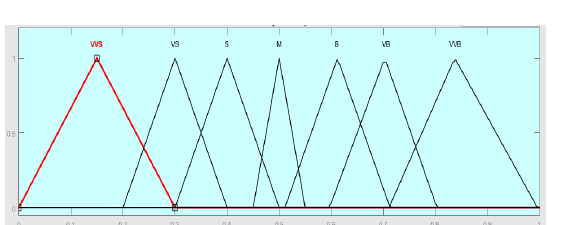
Fig.6: Membership functions of output variable